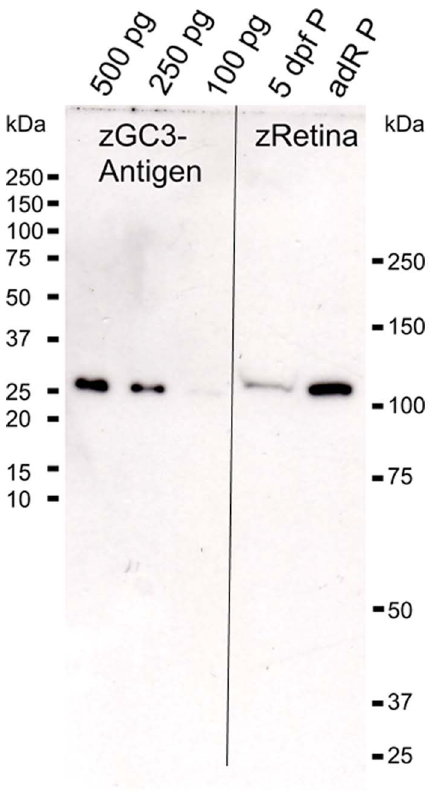
Figure 4. Quantitative estimation of zGC3 in adult zebrafish retina by western blotting. Different amounts of zGC3 antigen (100 pg, 250 pg and 500 pg) were used as calibration standards and compared with the pellet fraction of 5 dpf old larva eyes (10 eyes were used for homogenization) and of 1/10 of an adult retina (adRP). doi:10.1371/journal.pone.0069656.g004 guca1c gene (Figure 6A), since protein extracts from WT larval eyes at stages 5 and 6 dpf were probed by immunoblotting and contained zGCAP3, whereas samples of the morphant larvae showed no zGCAP3 expression. Injection of a control morpholino probe left the expression of zGCAP3 intact (Figure 6A, lane labelled C-MO).